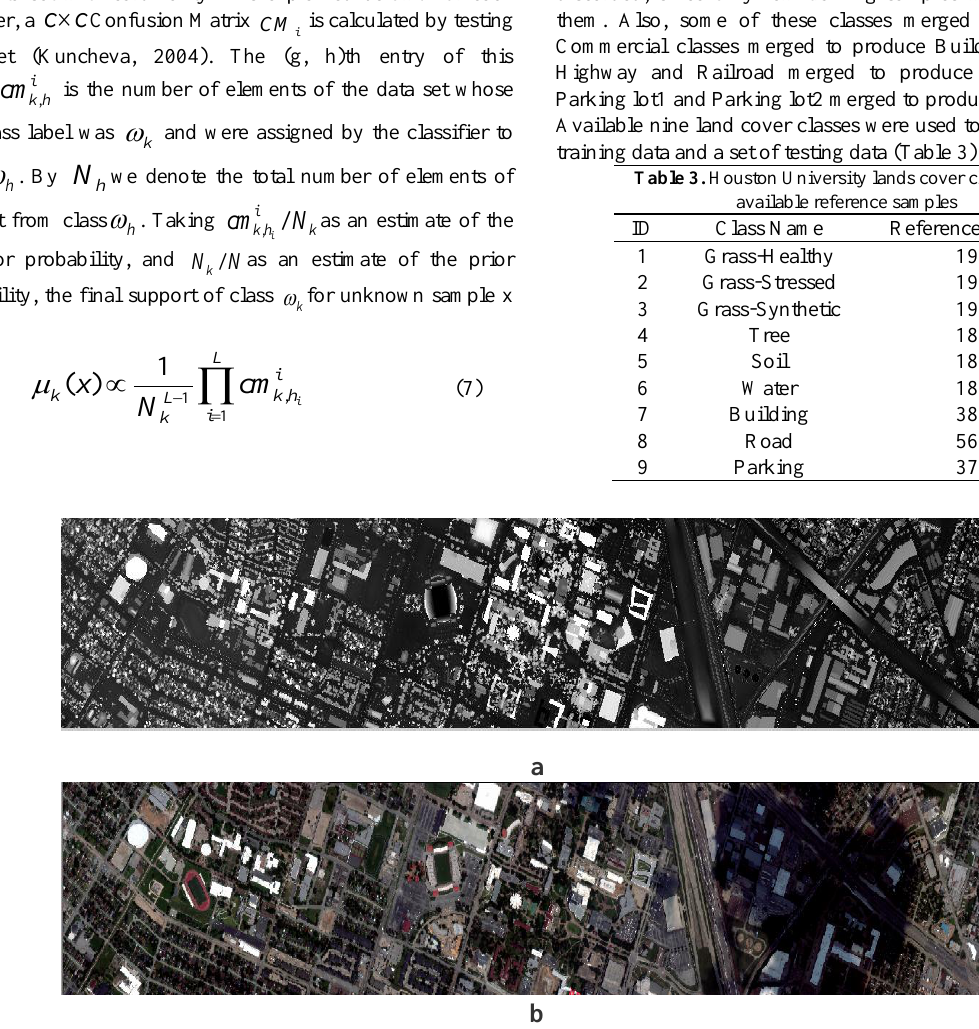
Figure 2. Data sets a)LIDAR derived DSM and b) hyperspectral data over Houston